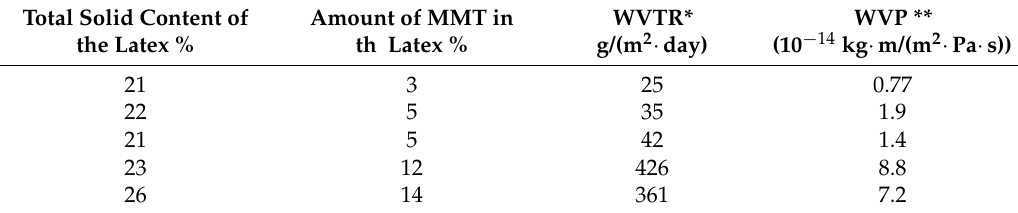
Table 2. Water vapor barrier properties of bare PLA/MMT